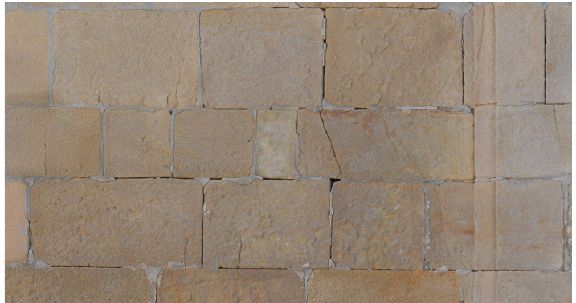
Figure 4. Sandstone masonry of the tower bell, built with the same local material (Pilia E.)